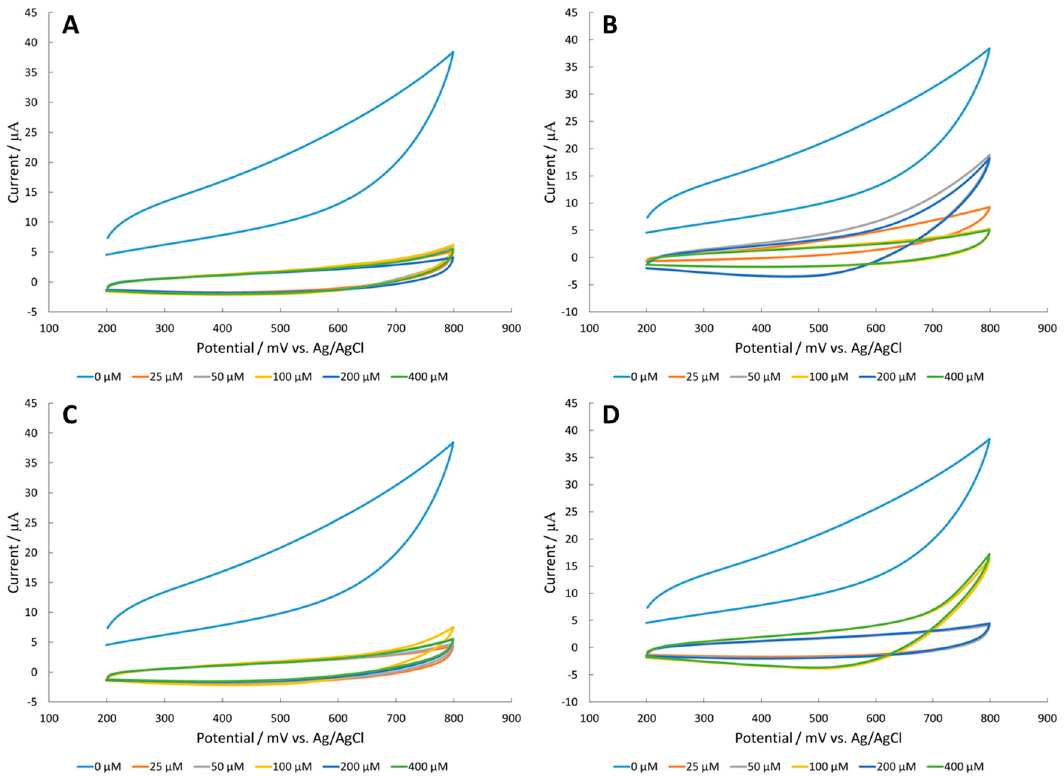
Figure 3. Cyclic voltammetry (CV) of ( A ) alanine, ( B ) arginine, ( C ) serine, and ( D ) valine in 100 mM NaOH with a CuO modified platinum working electrode.